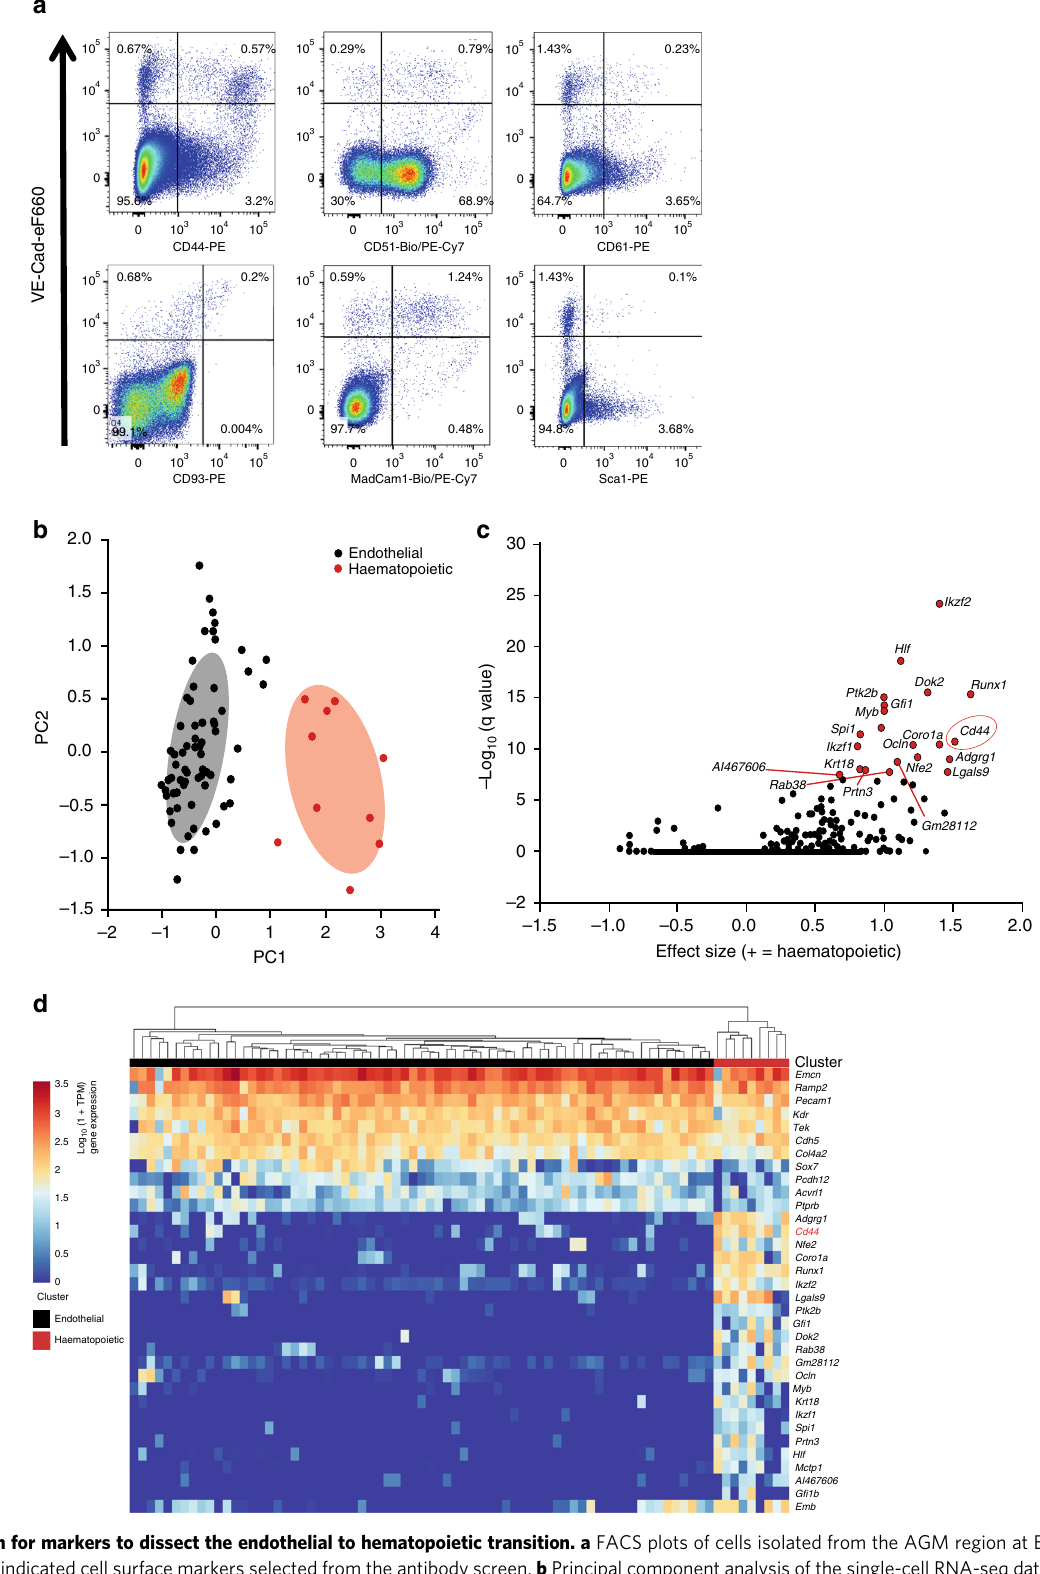
Fig. 1 Search for markers to dissect the endothelial to hematopoietic transition. a FACS plots of cells isolated from the AGM region at E11, stained with VE-Cad and indicated cell surface markers selected from the antibody screen. b Principal component analysis of the single-cell RNA-seq data done at E10.5. Cells expressing haematopoietic genes are marked in red, while the other cells are marked in green. c Volcano plot showing a selection of marker genes speci fi c to the group of cells expressing haematopoietic genes. Cd44 is highlighted with a red circle. d Heatmap displaying the expression of a selection of genes in the endothelial and haematopoietic clusters. Cd44 is highlighted in red. See also Supplementary Fig. 1 and Supplementary Data